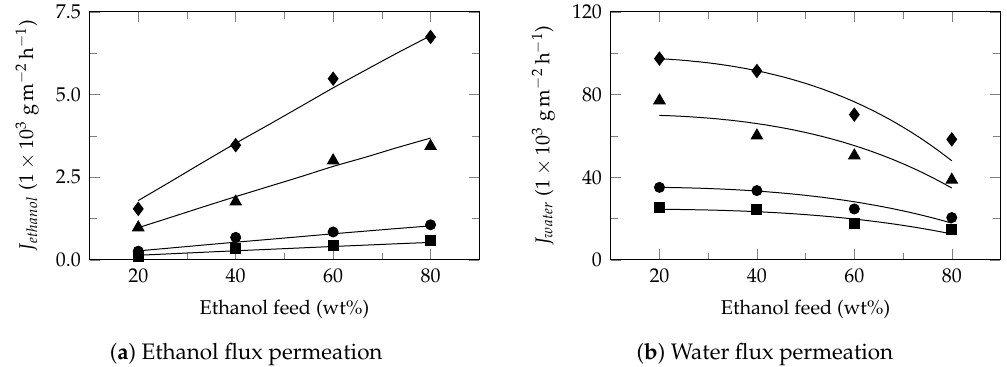
Figure A6. Ethanol dehydration. Experimental data extracted from Chen et al. 2010 [81]. Experimental flux (symbol) and